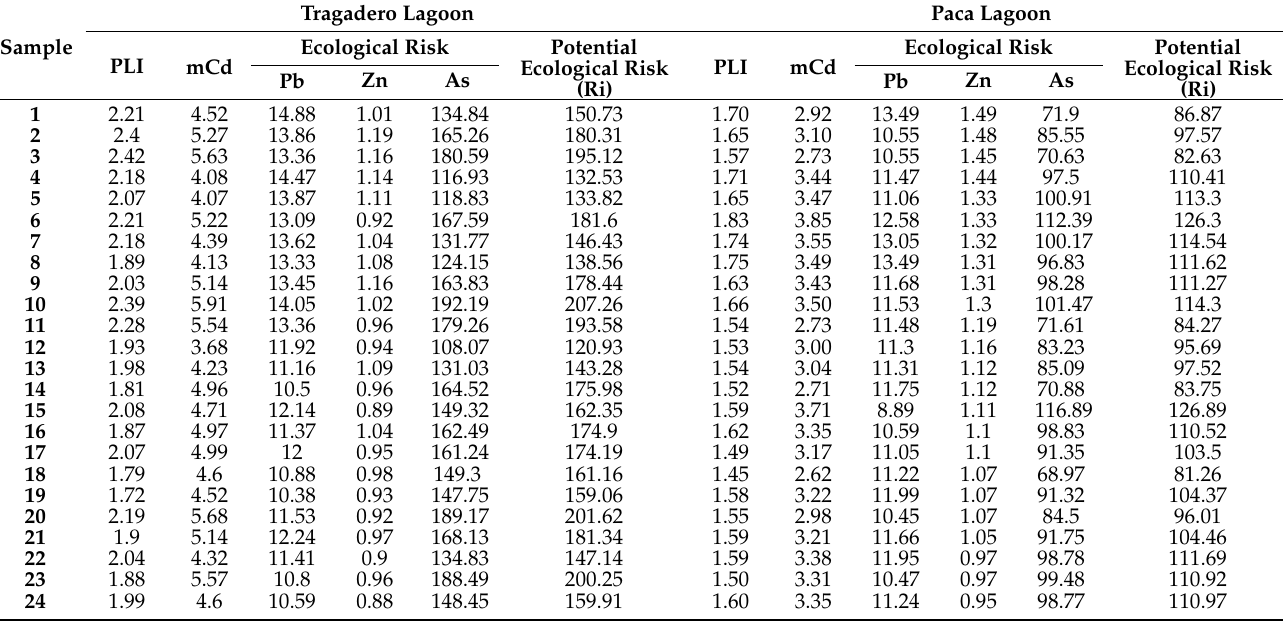
Table 2. Ecological risk and potential ecological risk values of the sediment samples collected in the Tragadero lagoon.